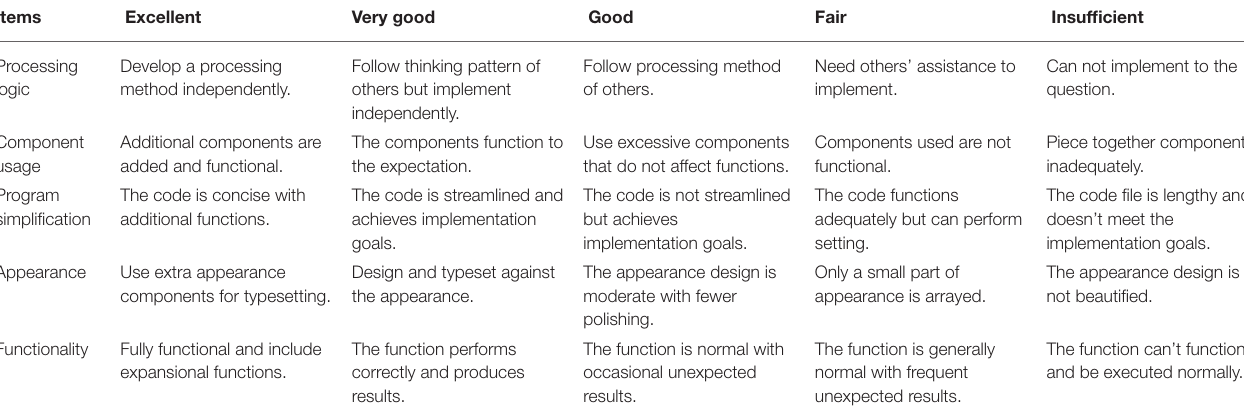
TABLE 2 | Peer assessment